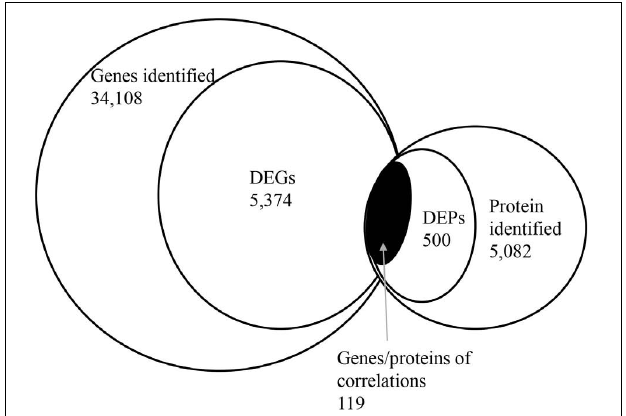
FIGURE 5 | Correlation between differentially expressed proteins and genes. The numerical value in each circle represents the quantity of genes or proteins, including identified genes and proteins, and genes or proteins related to heat acclimation respectively, and genes/proteins related to heat acclimation